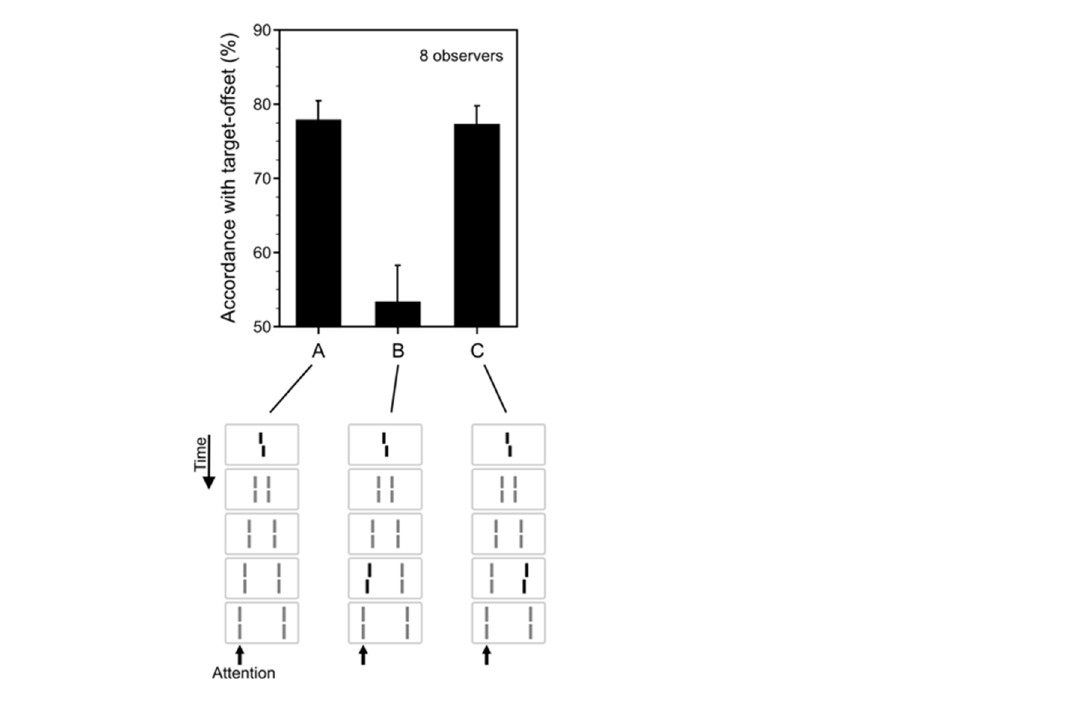
Figure 3. Sequential Metacontrast. A central line is followed by flanking lines at distances increasingly further away in space. In the experiments, observers attended, say, to the left stream and reported the perceived offset of the elements in the left stream. The reported offset direction was largely in agreement with the offset direction of the invisible central line ( A ). Hence, an invisible element can transfer its features to visible elements in a rather predictable manner. When one of the lines was offset in the opposite direction than the central vernier, the two offsets cancelled ( B ). When the line was offset in the non-attended, right stream, no integration occurred ( C ). Integration occurs only within a stream, i.e., a perceptual group. From Ref.